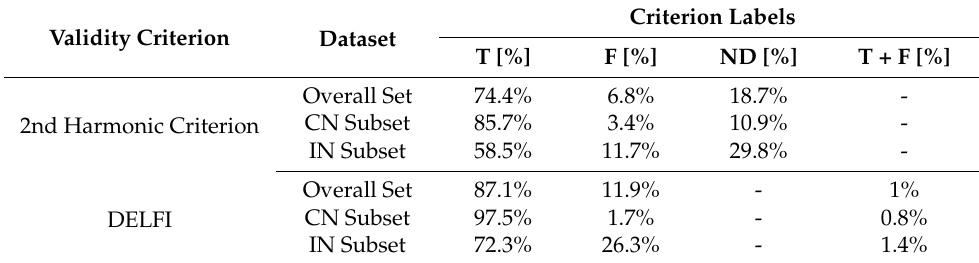
Table 4. Criteria Comparison: 2nd Harmonic and DELFI for each subset considered and for each class of events expressed as a percentage of the totality of